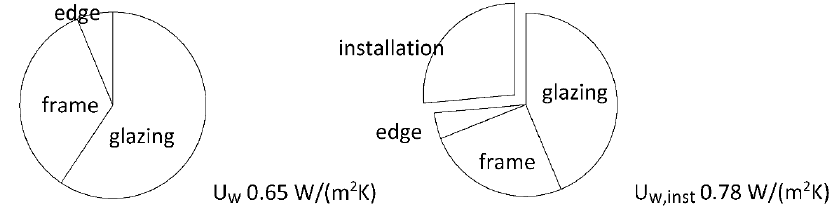
Heat transfer ( left ) and heat transfer including the e ff ect of installation on roof thermal coupling ( right )